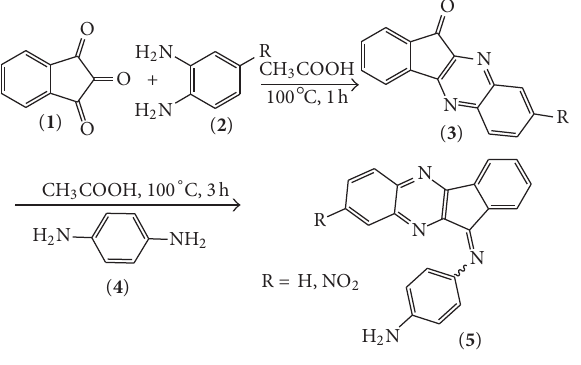
F 2: Synthesis of derivatives of (11H-indeno[1,2- b]quinoxaline-11-ylidene)benzene-1,4-diamine.